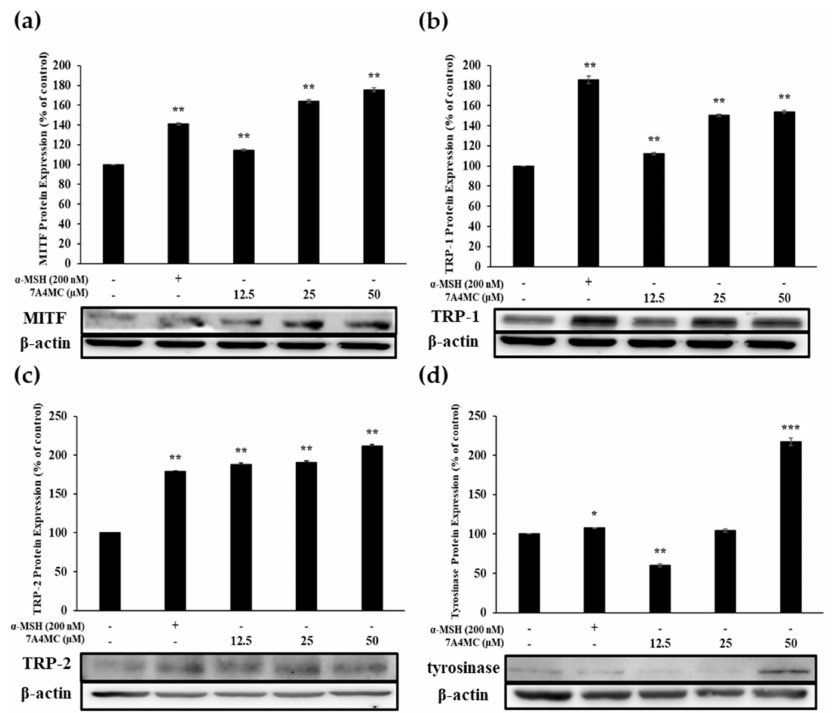
Figure 5. E ff ect of 7A4MC on MITF, TRP-1, 2, and TYR expression in B16F10 melanoma cells. Cells were treated with di ff erent concentrations of 7A4MC (12.5, 25, and 50 µ M) for 48 h. α -MSH (200 nM) was used as positive control. ( a ) Result of Western blot and protein level of MITF, ( b ) TRP-1, ( c ) TRP-2, and ( d ) TYR. The data represent the mean ± SD of triplicate experiments. * p < 0.05, ** p < 0.01, *** p <